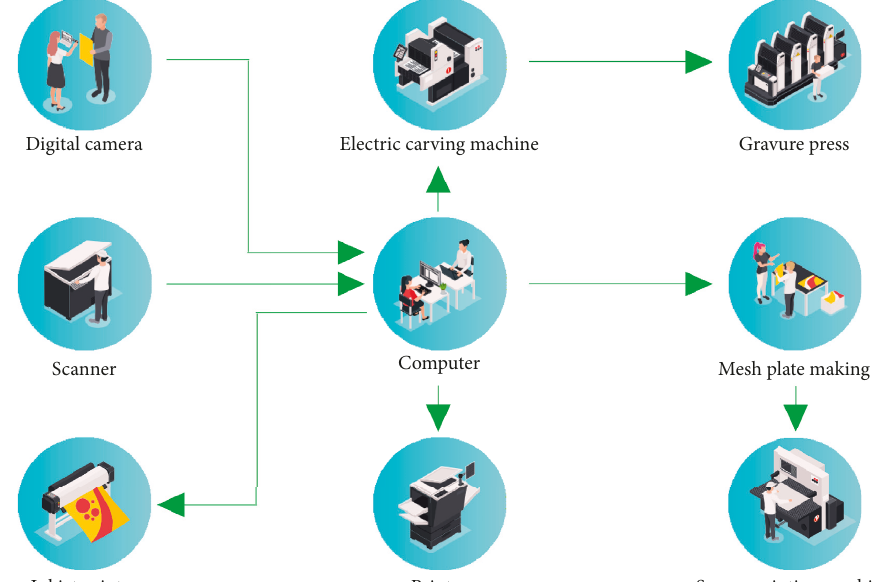
Figure 1: Packaging and printing